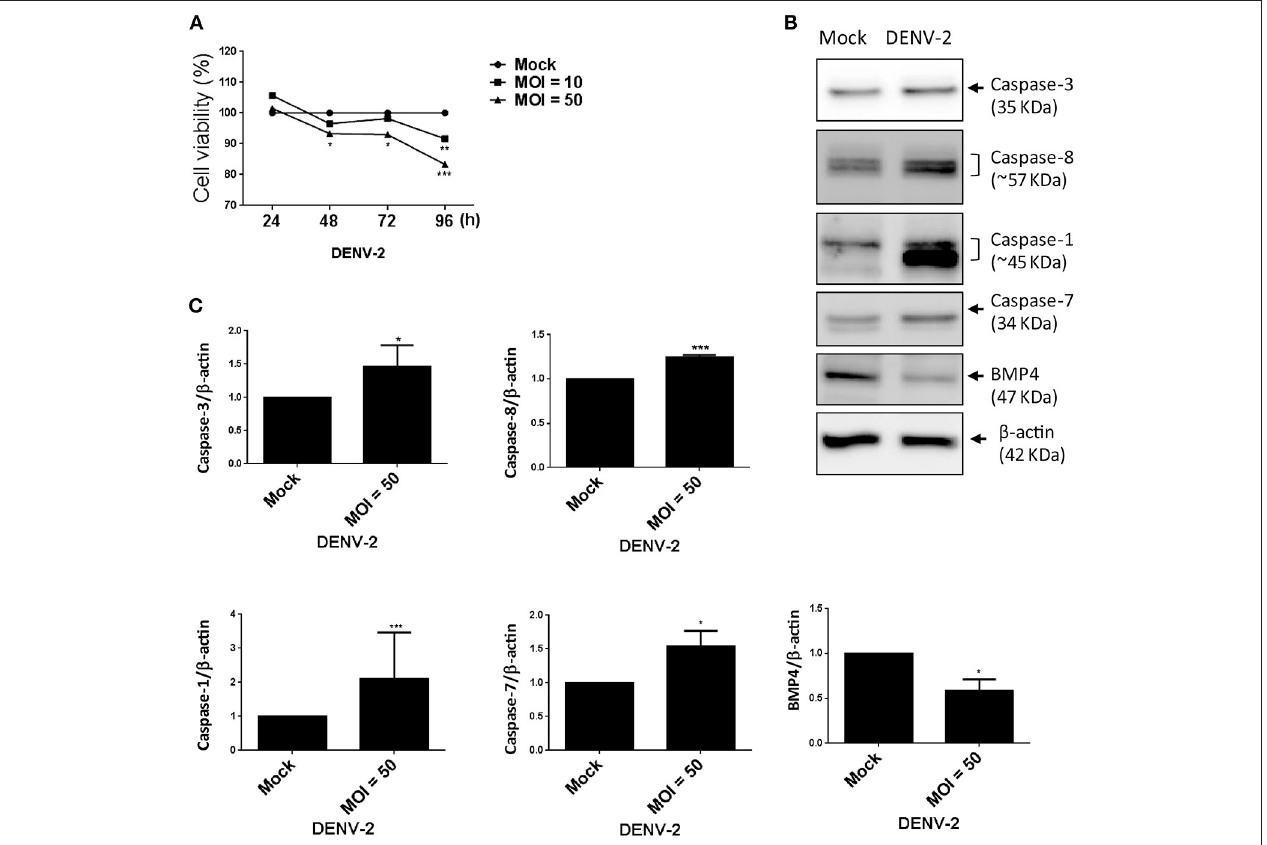
FIGURE 5 | DENV-2 induces cell-damage and apoptosis pathway in HFDPCs. (A) HFDPCs (4 × 10 4 cells/well) were infected with DENV-2 (MOI = 10 and 50), and cell viability was detected by WST-1 assay at 24, 48, 72, and 96h postinfection. Data are mean ± SD from three independent tests. * P < 0.05, ** P < 0.01, *** P < 0.001 vs. untreated control. (B) Western blot analysis of protein expression of caspase 3, caspase 8, caspase 1, and caspase 7, and BMP-4 in HFDPCs (2 × 10 5 cells/well) infected with DENV-2 (MOI = 50) for 4 days. β -actin expression was an internal loading control. The full membrane images are shown in Figure S4 . (C) Quantification of protein levels (mean ± SD) from three independent assays. * P < 0.05 and *** P < 0.005 vs. untreated control.